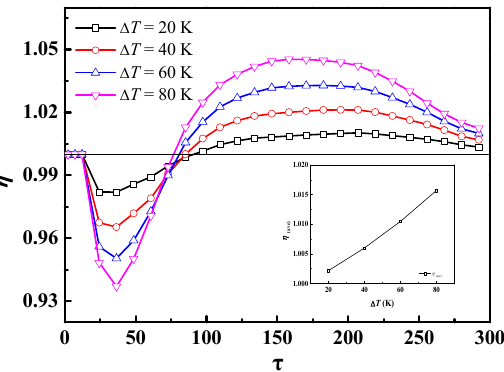
Figure 9. Dimensionless time dependence of m ‐ PCMs effectiveness η (inset is the average η (ave) overall η by integrating over the distribution).